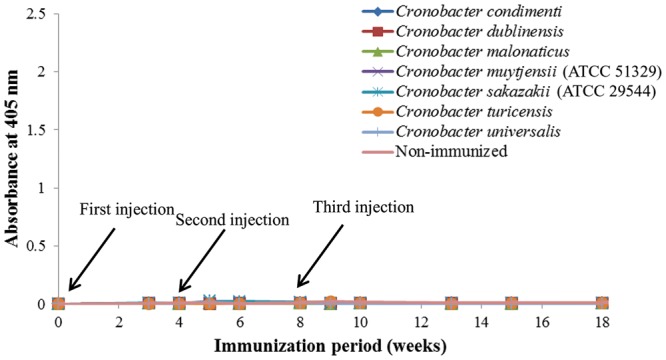
Titers of rabbit anti-serum developed by lipopolysaccharide against seven Cronobacter species. All experiments were conducted three times, and data represent mean ± standard deviation.